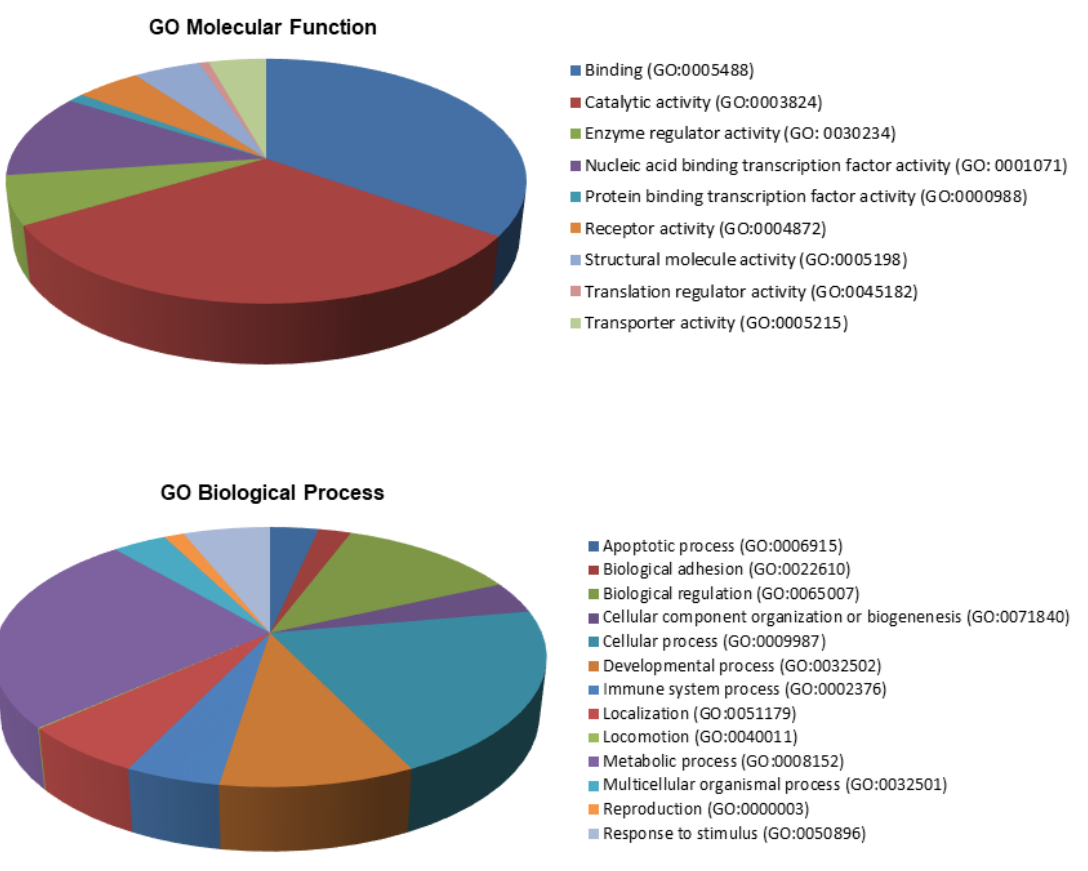
Figure 6. Classification of validated targets by gene ontology (GO) molecular function and biological processes. Summary of molecular functions and biological processes for validated target genes of miRNAs included in both clusters.